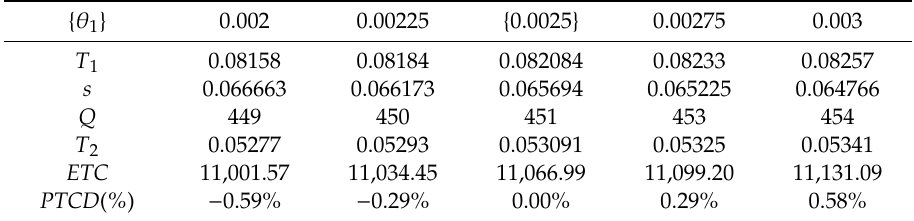
Table 3. Sensitivity analysis when defective rate before inspection changes.